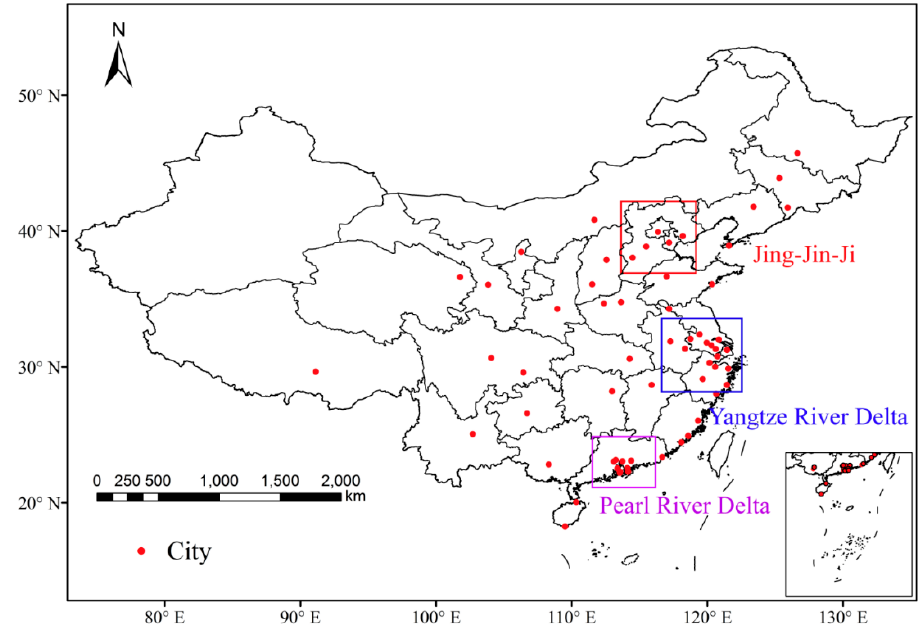
Figure 1. Study area with cities in Jing-Jin-Ji (north), Yangtze River Delta (middle) and Pear River Delta (south) in China.